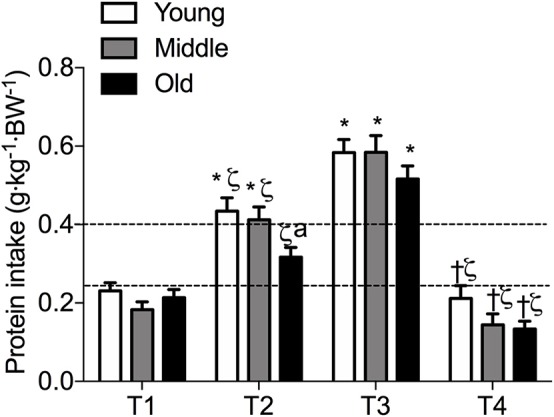
Meal-specific average protein intakes in young, middle-aged and older individuals. Dashed lines represent threshold protein intakes of 0.24 and 0.4 g·kg−1, suggested for maximal stimulation of MPS in young and older individuals, respectively. *indicates significantly different from T1, ζ indicates significantly different from T3, †indicates significantly different from T2, aindicates significantly different from young at same time-point. Significance was set at P < 0.05.